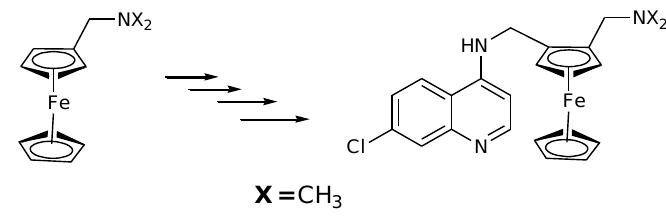
Figure 1. Synthesis of ferroquine by Biot and co-partners.